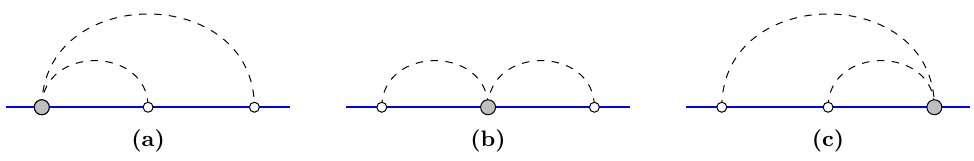
Figure 3. Diagrams with purely bosonic contractions. White bubbles represent the two local operator insertions, whereas the grey one is the bosonic part of the L superconnection coming from the first order expansion of W. The diagrams take into account all possible path orderings of the